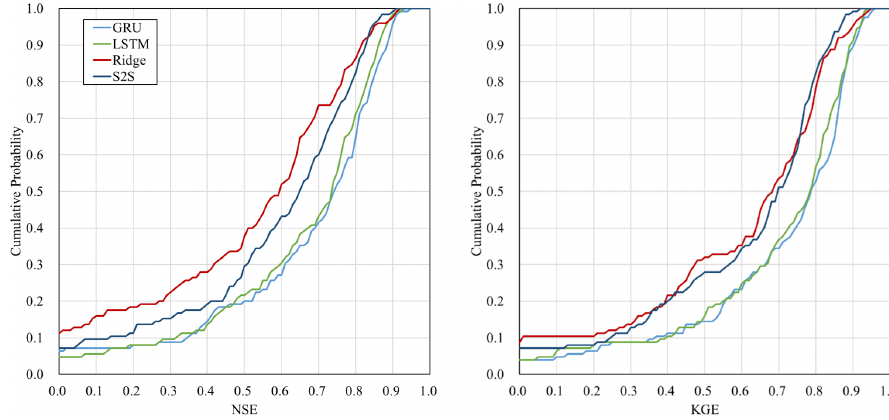
Figure 5. Cumulative probability curve of the NSE and KGE at the 120h forward predictions.